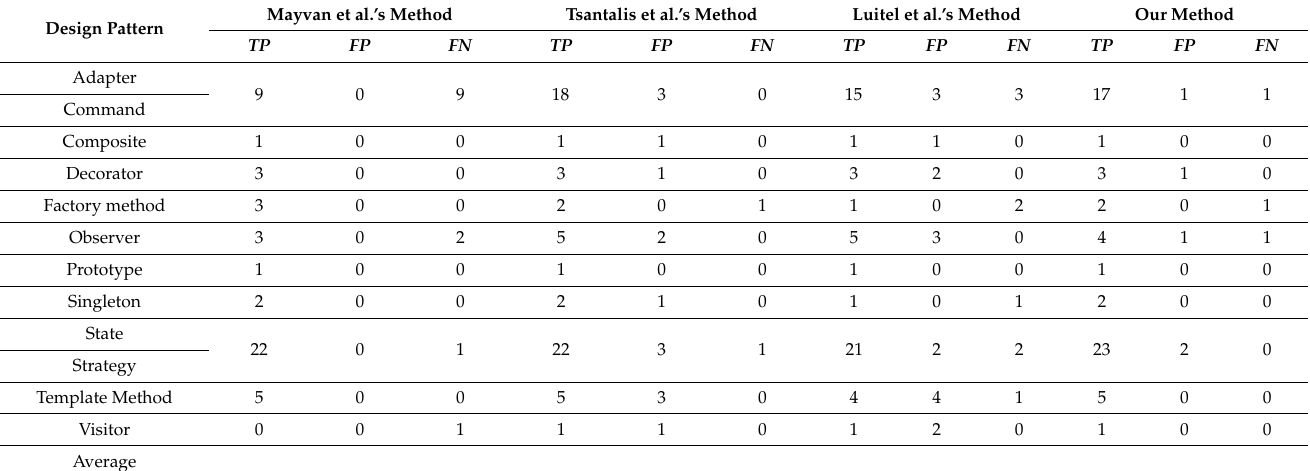
Table 2. The number of true positive instances, the number of false positive instances and the number of false negative instances in JHotDraw 5.1.